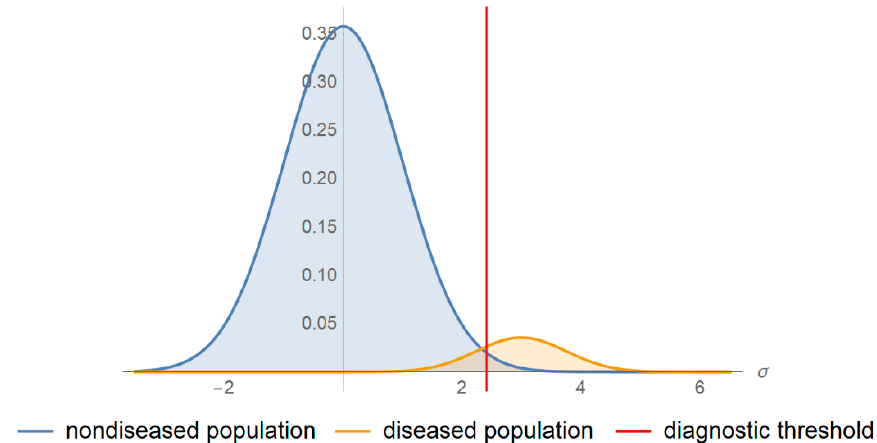
Figure 1. Probability density function plots. The probability density function plots of a measurand in a non-diseased and diseased population. Table 1. A 2 × 2 contingency table.